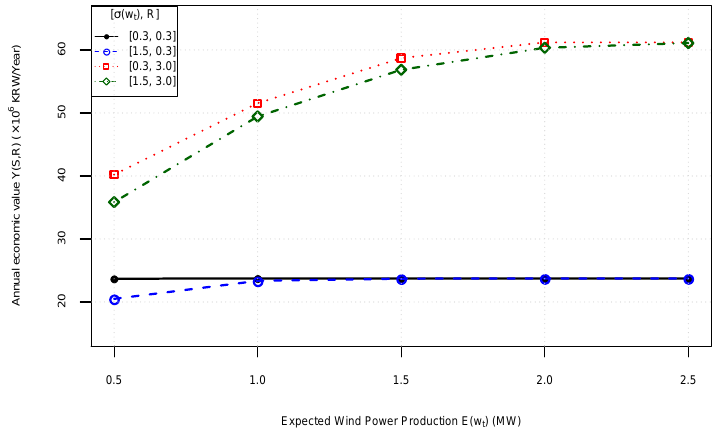
Figure 12. Annual economic values Y ( S , R ) for different mean and standard deviations of wind ( m , h ) electricity model, ¯ w and σ ( w t ) . ( S = 1.5 MWh). t